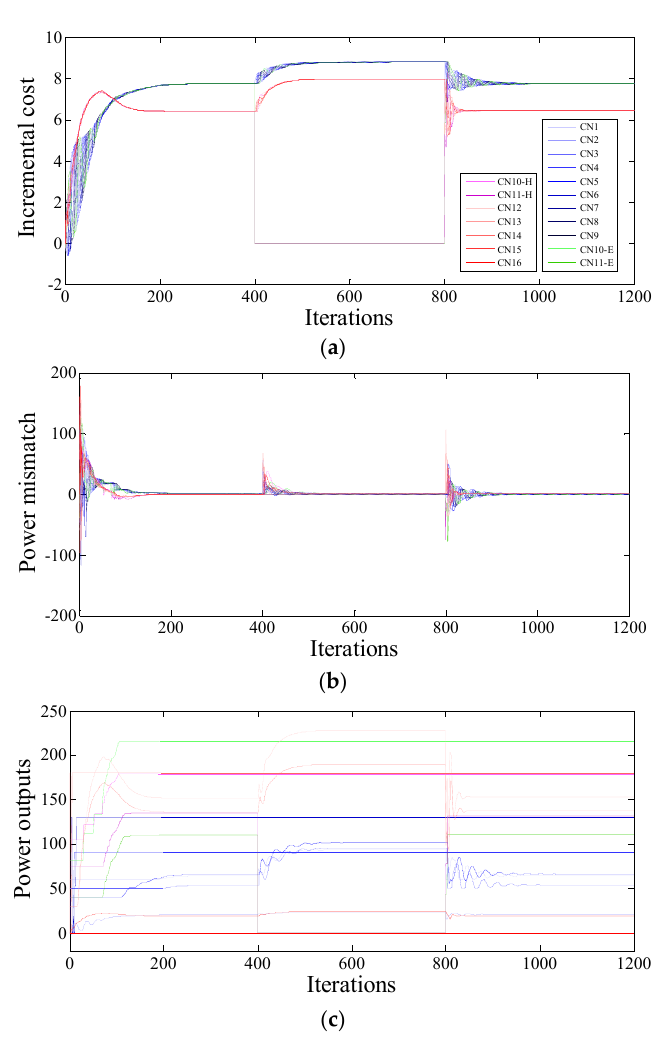
Figure 7. Case study 3, plug and play test: ( a ) estimated electrical and heat incremental cost; ( b ) estimated electrical and heat power mismatch; and ( c ) electrical and heat power outputs.